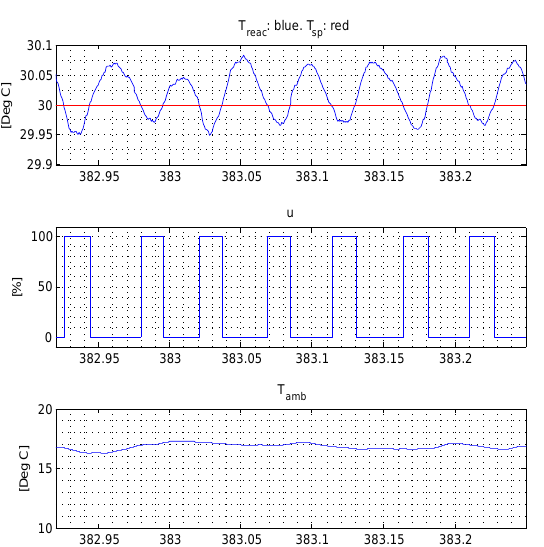
Figure 5: Real time-series for the reactor with on-off temperature control. T reac is filtered with time-constant 10 min. The sampling time- step of time-series is 15